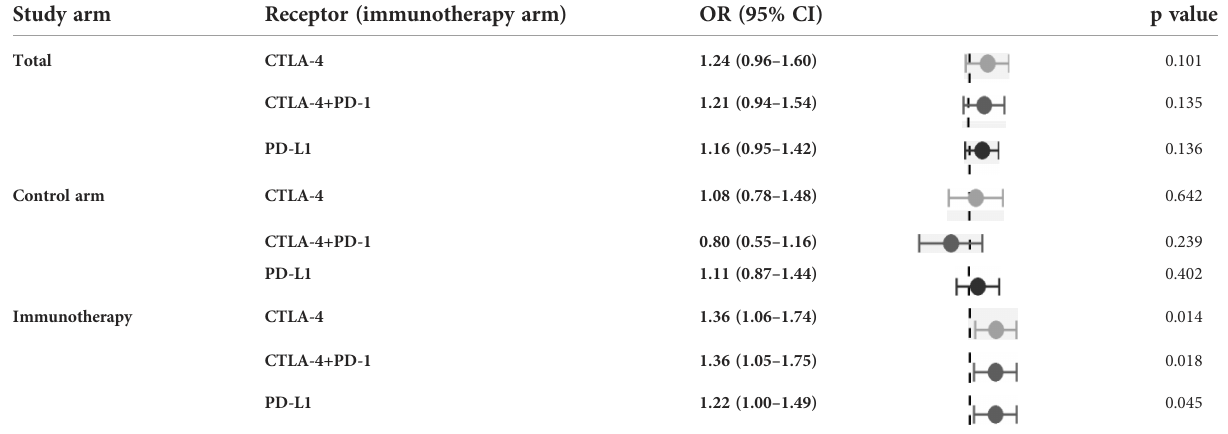
TABLE 3 Odds ratio of insomnia according to type of immunotherapy (antiPD-1 agents as reference). Study